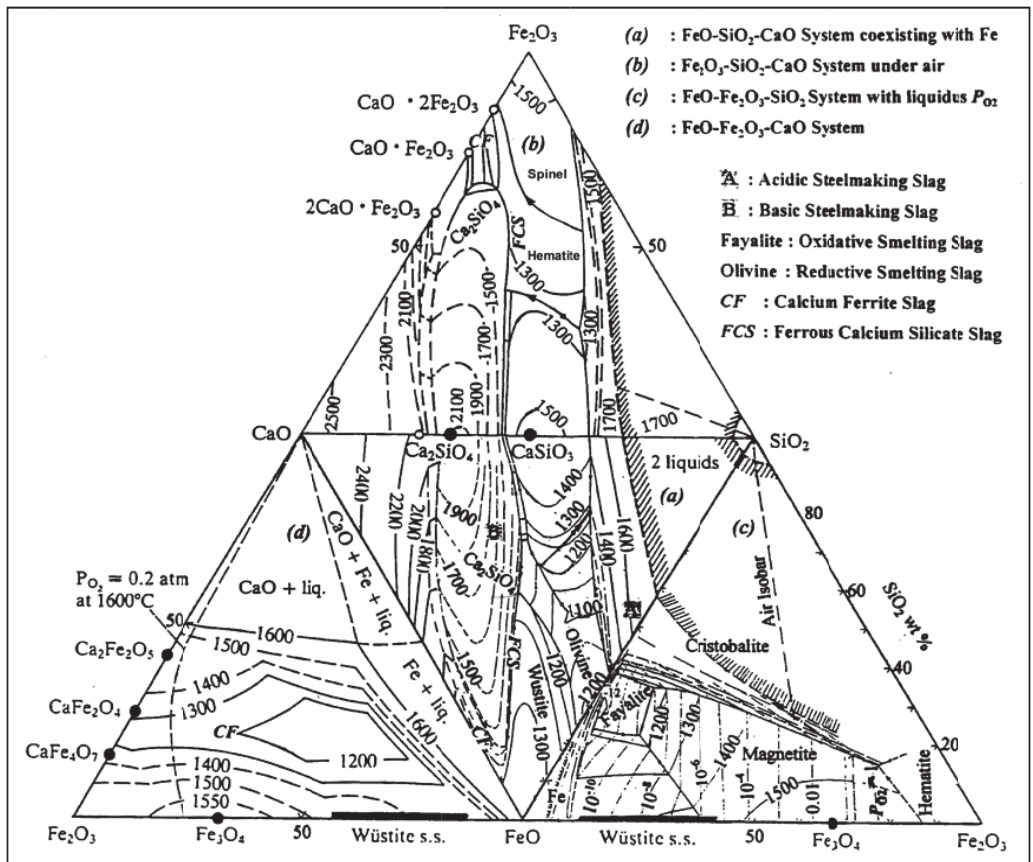
Figure 1. Phase diagram of (a) FeO-SiO 2 -CaO-system in contact with metallic iron, (b) Fe 2 O 3 -SiO 2 -CaO in air, (c) FeO-Fe 2 O 3 -SiO 2 , (d) FeO-Fe 2 O 3